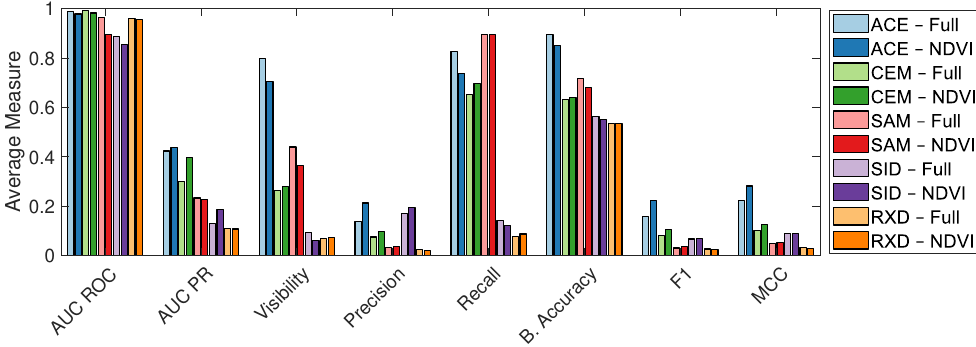
Figure 8. Average performance of each TD and DR algorithm combination when used on the full scene vs. when combined with spatial